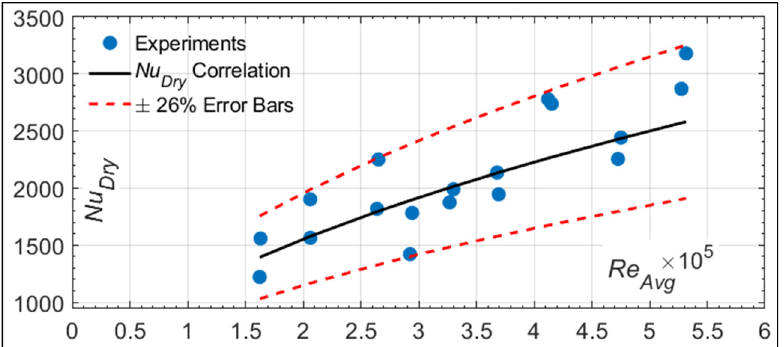
Figure 19. Comparison of the Nu Dry Correlation Predictions Versus Experimental Measurements of this Work.